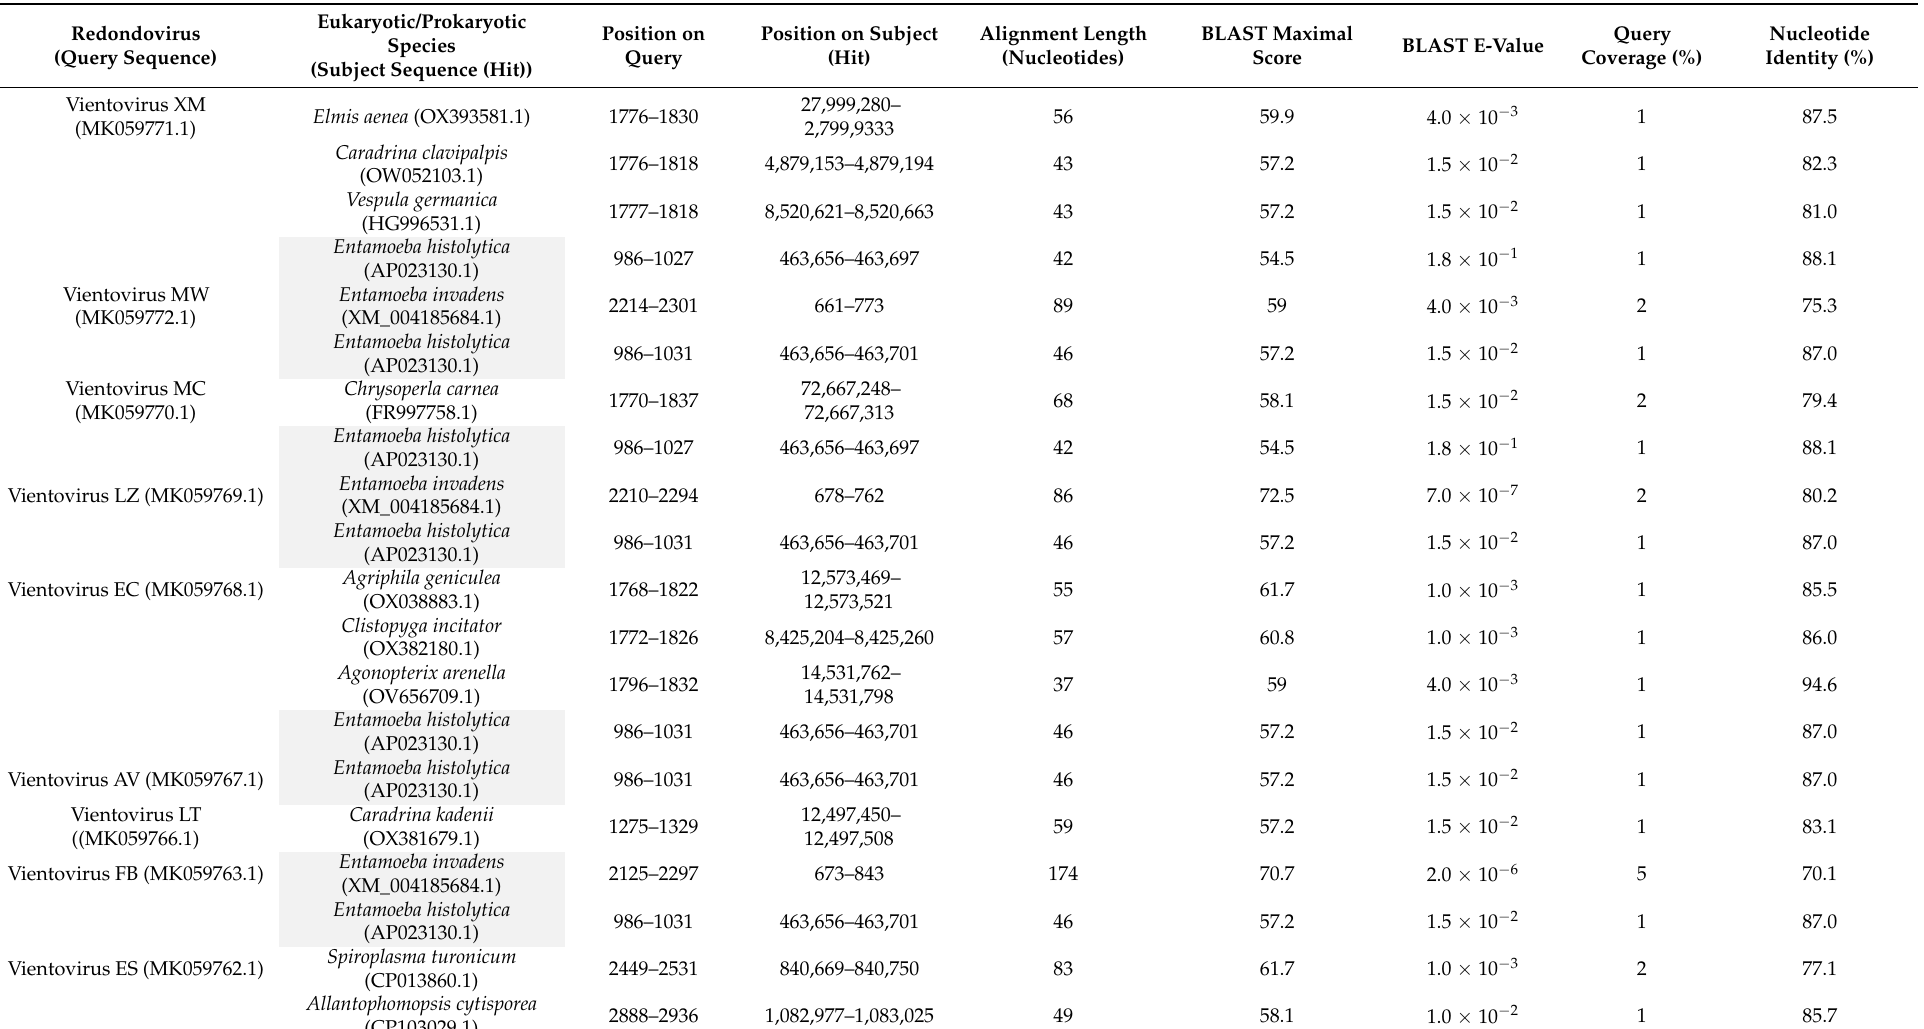
Table 1. BLAST search results (best hits) for the 52 redondovirus genomes against eukaryotic/prokaryotic sequences from the NCBI GenBank database. Redondovirus (Query